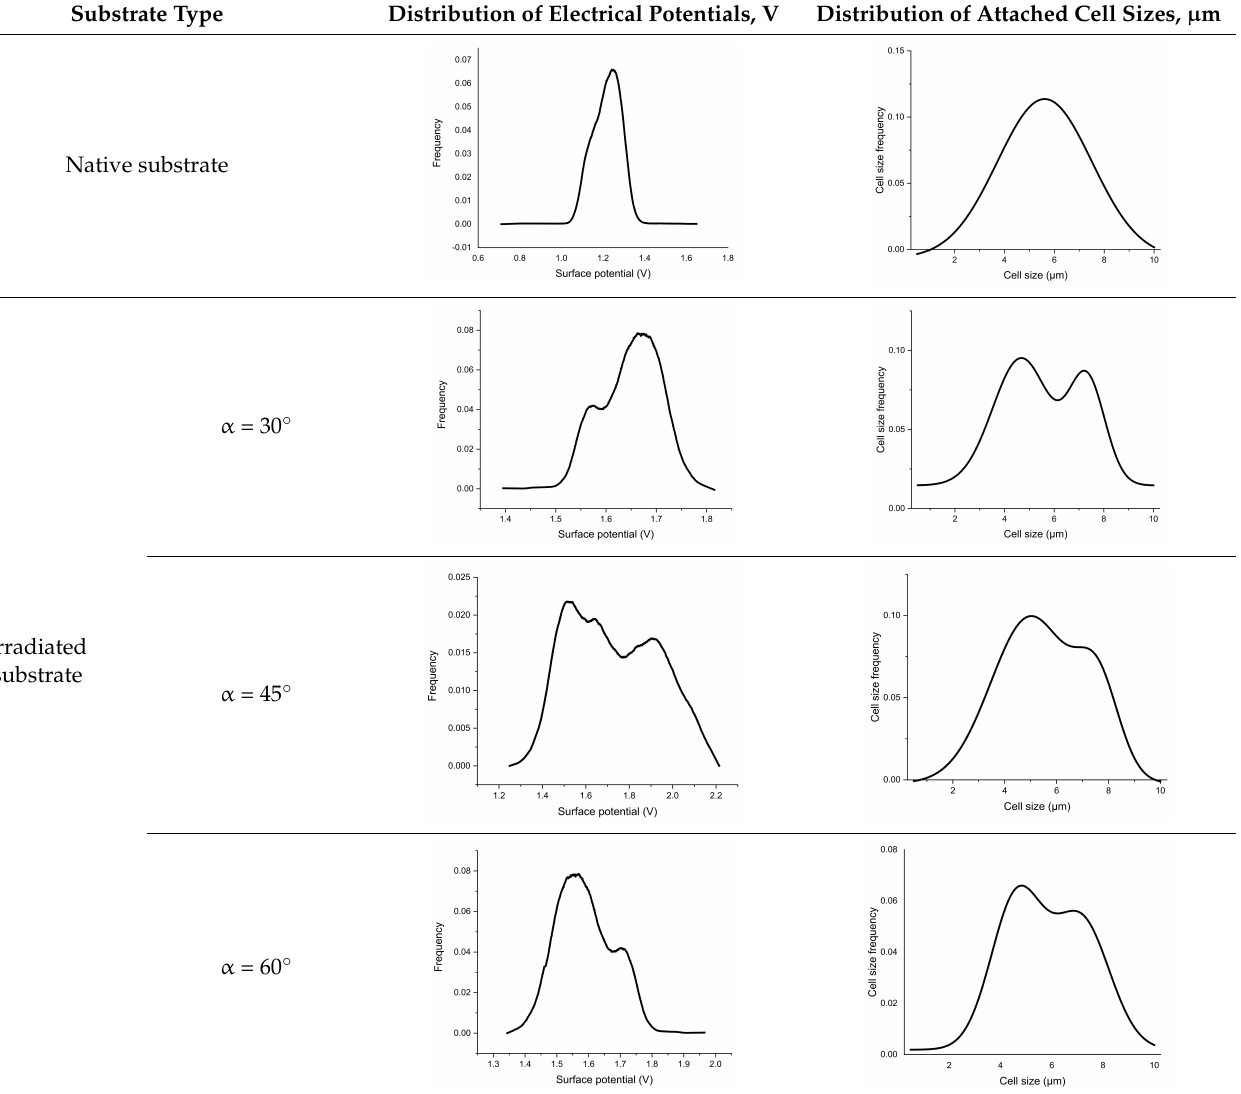
Table 2. Histograms of the surface electrical potential and immobilized cell size